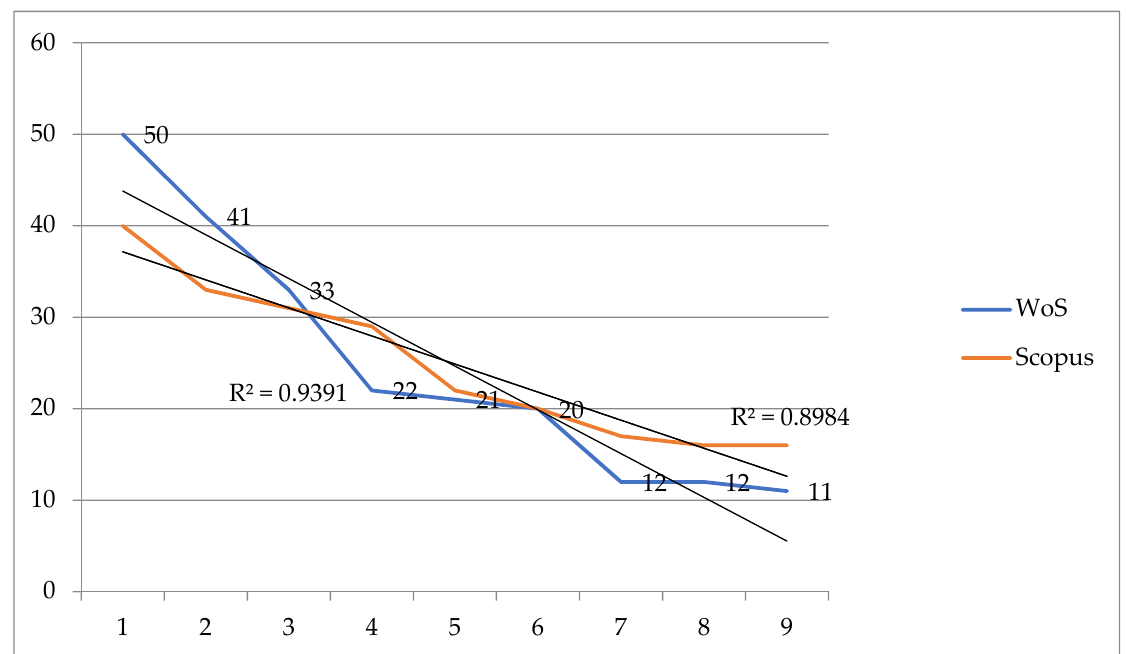
Figure 4. Personal production of the scientific production indexed in the Web of Science and Scopus databases.